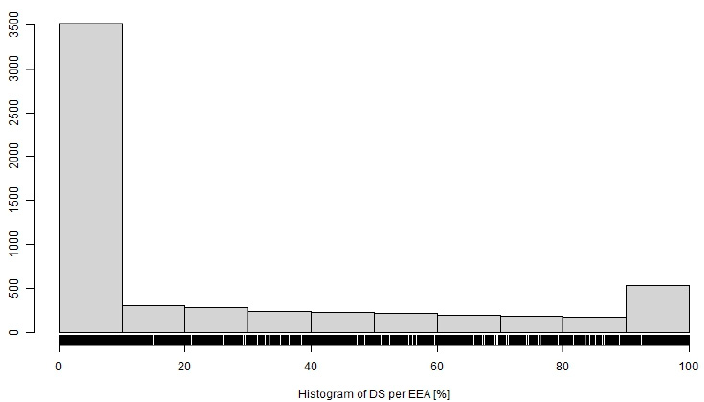
Figure 7. Distribution of EEAs by percentage of drainage systems (DS). Characteristics of horizontal axis are as follows: Min.: 0.00%; Q1: 0.00%; Median: 0.00%; Mean: 23.45%; Q3: 43.00%; Max.:100.00%; SD: 33.62%.